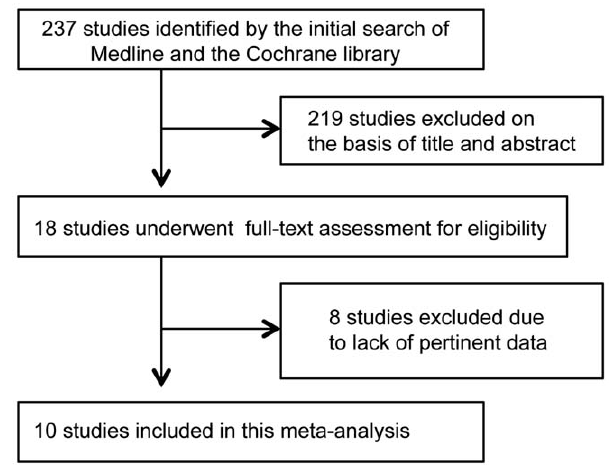
Figure 1. Flow diagram of study selection.